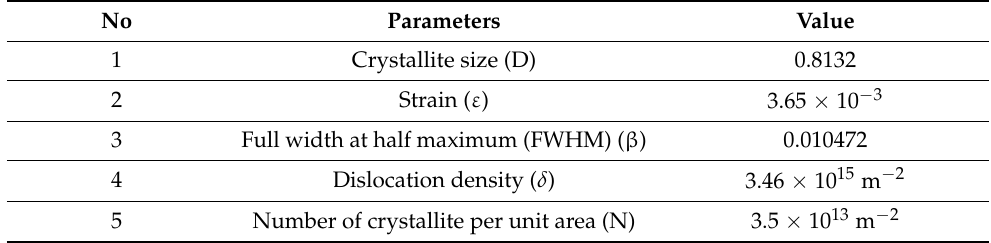
Table 2. Structural parameters of mango Fe 3 O 4 /C calculated from Debye–Scherrer equation.